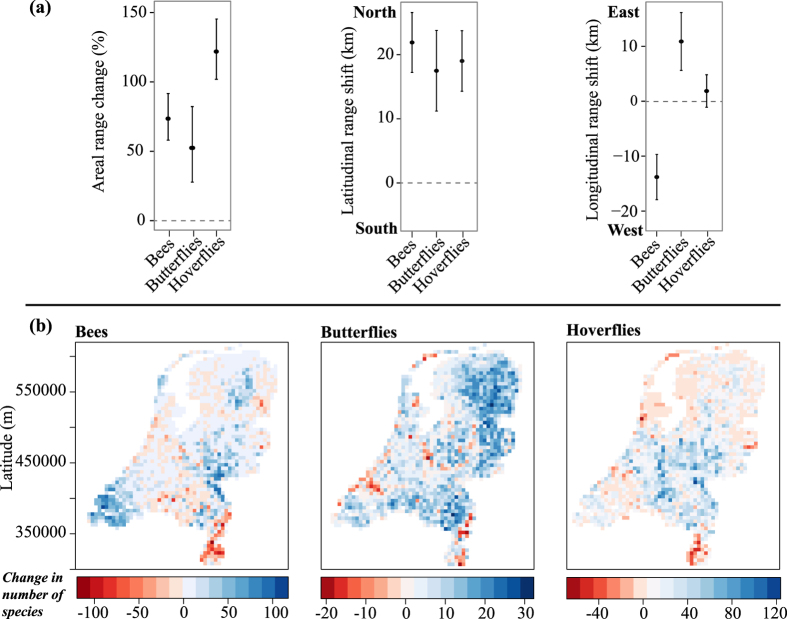
Half-century changes in species distributions of Dutch pollinators (bees, butterflies, hoverflies).(a) Three aspects of species distributional changes between period 1 (1951–1970) and period 2 (1998–2014) are captured. Left: areal range changes (% change in geographic range size between periods) as obtained from back-transformed values of model estimates. Middle: latitudinal range shifts (latitudinal change of the range centroid between periods, with positive values representing northward shifts and negative values southwards shifts, in km). Right: longitudinal range shifts (longitudinal change of the range centroid between periods, with positive values representing eastward shifts and negative values westward shifts, in km). For all spatial range changes, the means ± 95% confidence interval across all species within a pollinator group are presented. For statistical details see Table S1. (b) Maps of net changes in the number of species per grid cell and pollinator group across the Netherlands. The maps illustrate the number of species colonising a grid cell between periods minus the number of species abandoning the same grid cell. Blue colours: grid cells with more range expansions than contractions. Red colours: grid cells with more range contractions than expansions. The maps were created using the R “raster” package (https://cran.r-project.org/web/packages/raster/index.html).